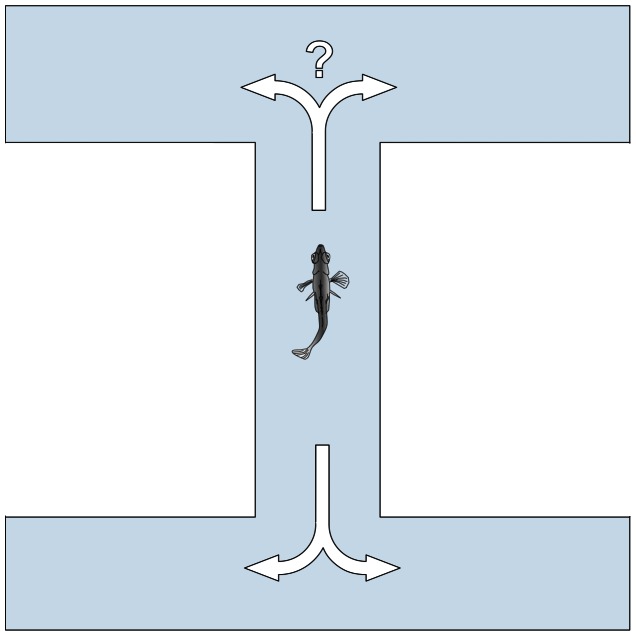
View from above of the double T-chamber used for lateralization tests.A turning choice is manually recorded every time the fish leave the central channel and enter one of the side channels. The use of a double T minimizes handling of the fish as multiple choice events can be performed by only gently encouraging the fish back along the channel.